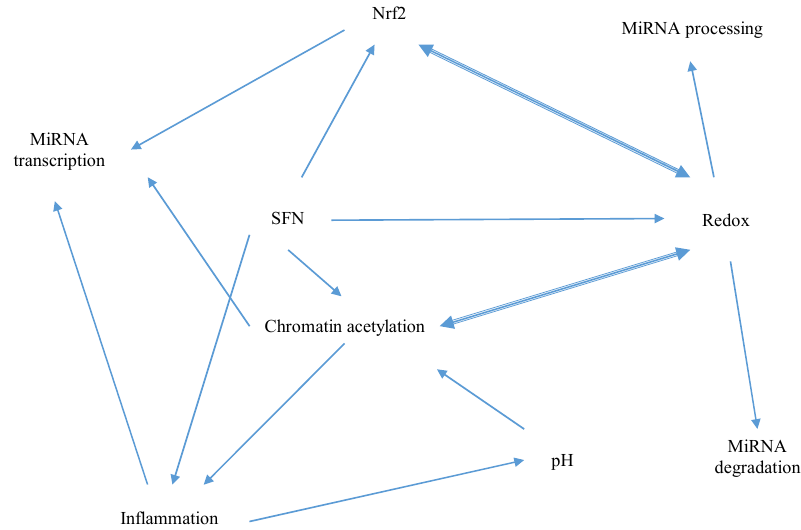
Figure 7. A diagram to illustrate the complexity of the network of cross-interactions between potential mechanisms of SFN-mediated miRNA modulation.